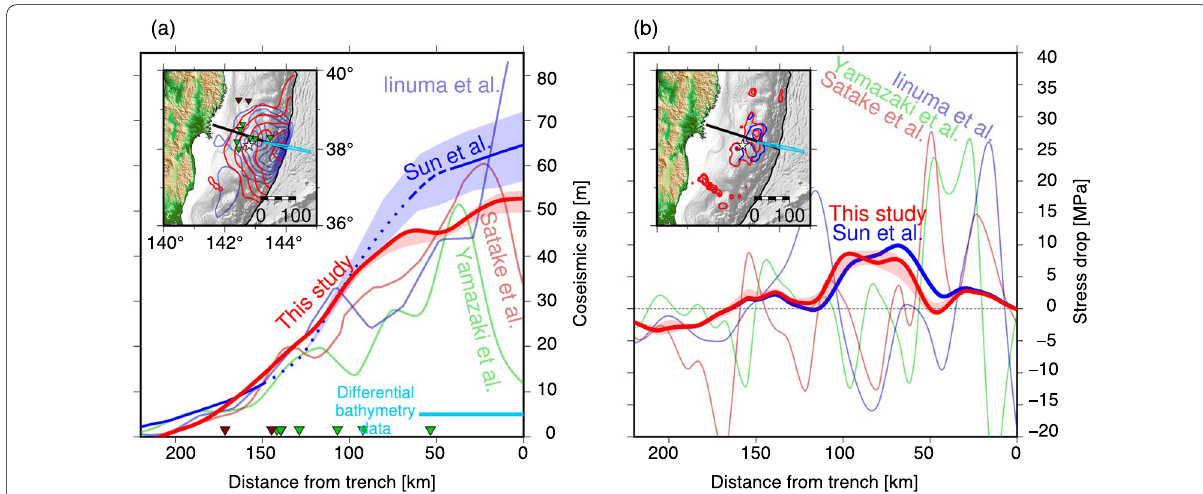
Fig. 7 Cross-sectional view of the fault slip and stress drop of the Tohoku-Oki earthquake. a Comparison of the fault slip distributions between the present study (red) and the ones in the previous studies (Iinuma et al. 2012; Satake et al. 2013; Sun et al. 2017; Yamazaki et al. 2018) along the line normal to the trench axis shown in the inset map. The error range of the present study’s model is shown by the red shaded area. The blue shaded area denotes the error range of Sun et al. (2017). The small triangles denote the location of the ocean-bottom pressure gauges. The region of the differential bathymetry survey conducted in Sun et al. (2017) is shown by the cyan line. b Comparison of the stress drop distributions. The error range of the present study’s model is shown by the red shaded